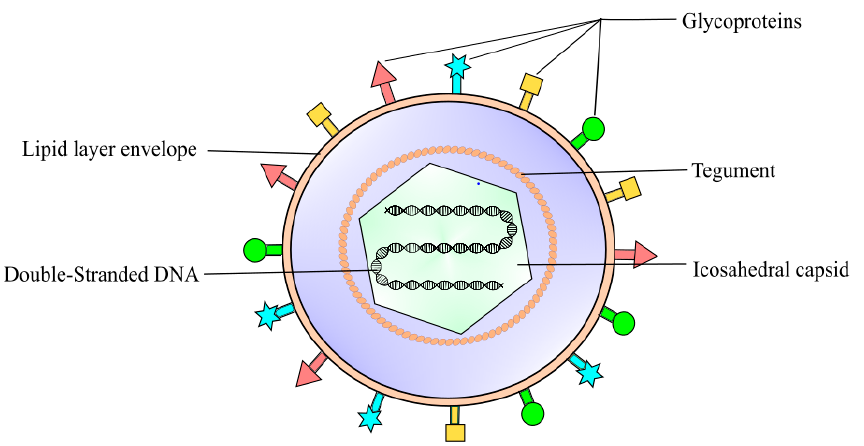
Figure 1. Herpes simplex virus 1 (HSV-1) is classified into the Alphaherpesvirinae family, a sub- family of Herpesviridae. It is an enveloped DNA virus consisting of a linear double-strand genome protected inside an icosahedral capsid. The inner tegument is made up of a layer of mRNA and proteins, whereas the outer lipid bilayer envelope contains glycoproteins. These glycoproteins are responsible for the invasion of the virus into the host cell.